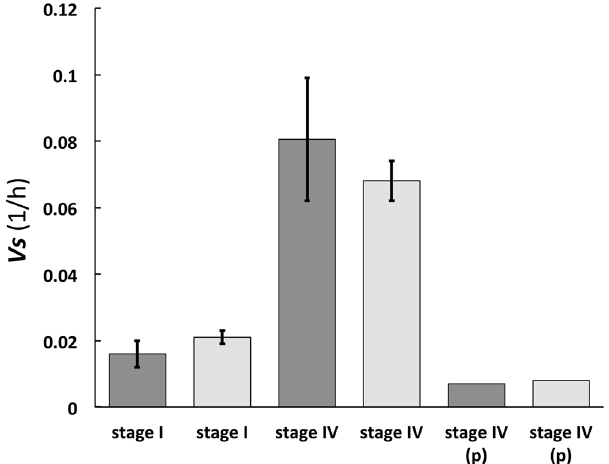
Figure 3. A comparison of v s values calculated (dark grey) and measured (light grey) for stage I and stage IV sporangiophores of P. blakesleeanus . Equation (10) is employed to calculate v s values (dark grey) using a constant value for Π pe ( Π pe = 1524) and using values for ε and φ taken from Ortega et al . 4, 6 ; see Calculations, Estimates, and Methods for details. The confidence intervals for the measured values (light grey) are standard errors taken from Ortega et al . 6 . The confidence intervals for the calculated values (dark grey) represents the maximum and minimum values that can be calculated from maximum and minimum values obtained from standard errors of ε and φ 6 . The measured v s value for the plucked (p) stage IV sporangiophore (light grey) is for a single